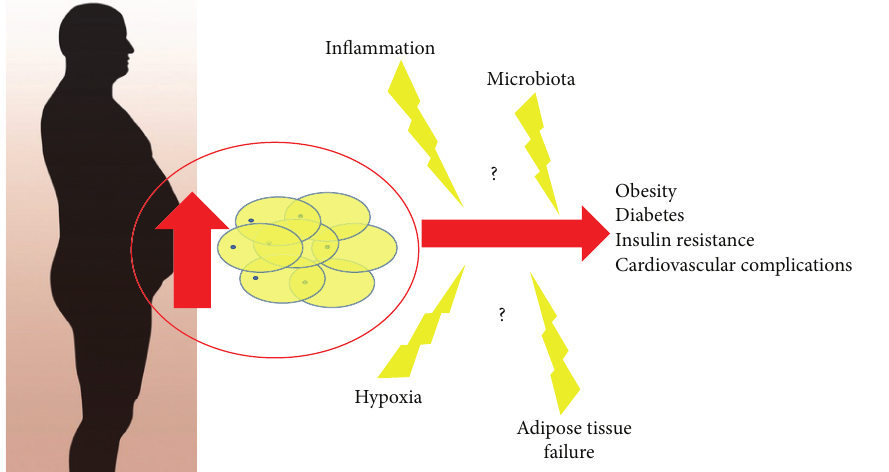
Figure 4: Fat accumulation leads to a high number of commorbidities associated to the metabolic syndrome. Many factors intervene in this situation. Many of them are known but not understood, many are even unknown, so research must be continue until we can elucidate how this great orchestra sounds in the right